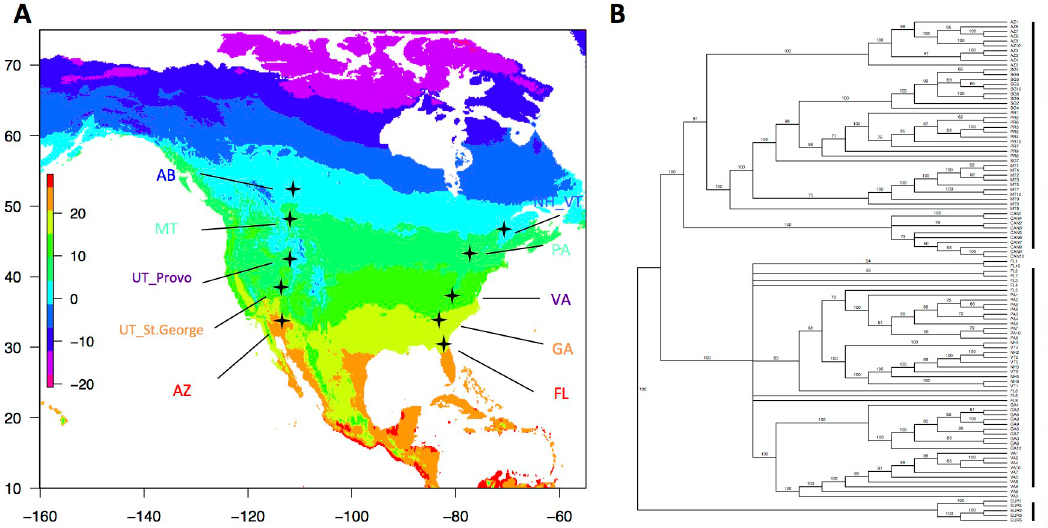
Fig 1. Sampling localities and relationships among populations. A) Heat map of mean annual temperature (MAT) in North America with the parallel eastern and western house mouse transects with populations at similar latitudes shown in the same color. Degrees of latitude are marked on the y-axis, longitude on the x-axis, and MAT in ˚C is indicated by color. This map was created using the R package “raster’ to plot Mean Annual Temperature data from worldclim (MAT = bioclim variable 1) . B) A bootstrap consensus neighbor-joining tree constructed in PAUP using a distance matrix generated from the exome sequences of all 100 mice in both the eastern and western transects depicting the relatedness among all 10 populations. This tree is rooted using five M . m . domesticus samples from Europe.